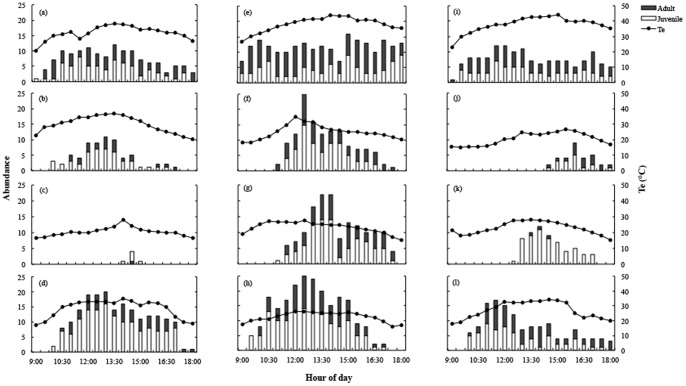
Number of juveniles (white bars) and adults (black bars) M. atacamensis lizards along the day in summer, fall, winter, and spring seasons for: Medano (a–d), Zenteno (e–h), and Arrayán (i–l) populations.Circles represent Te (measured with Tidbits data loggers).